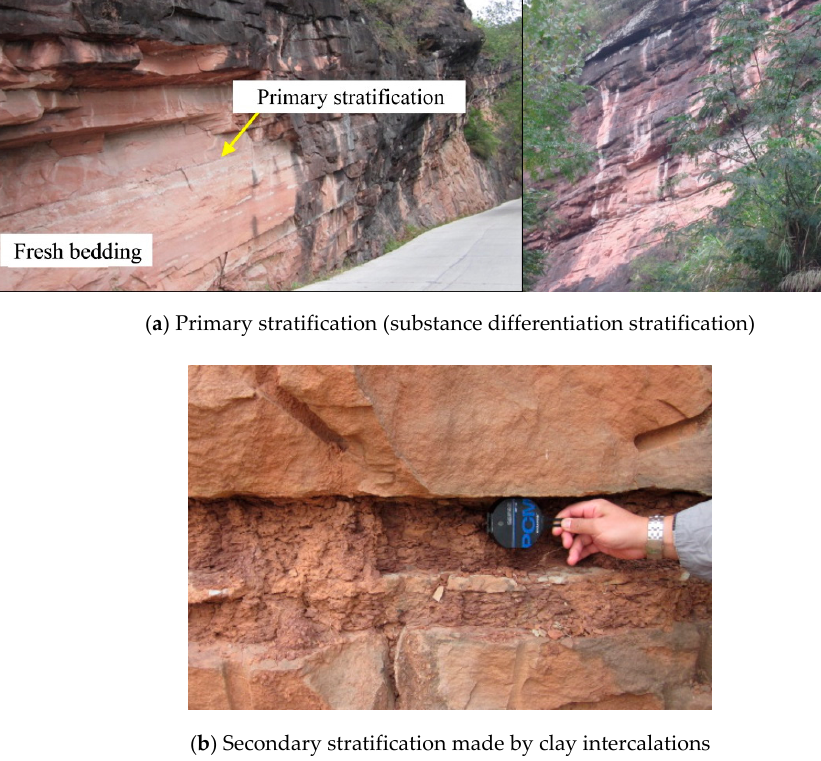
Figure 5. Two typical structural stratifications of red beds in South China.